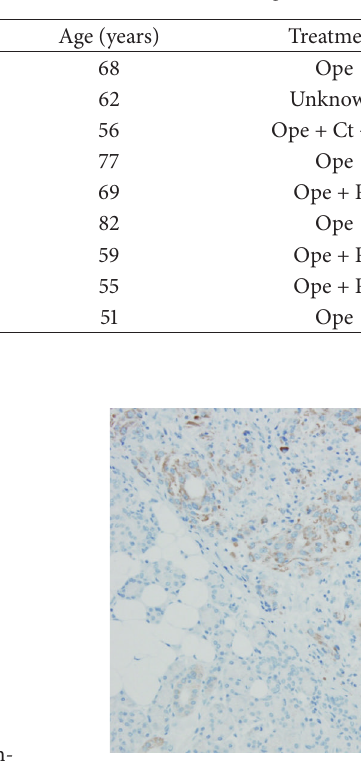
Figure6:Antimitochondrialantibodystainingshowingmoretissue with fine blue-stained granules than normal